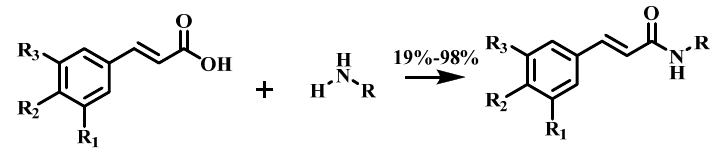
Scheme 1. General procedure for the synthesis of cinnamide derivatives. Reagents and conditions: Table 1. Structures of the synthesized compounds and their inhibitory potencies toward b-ARG I.